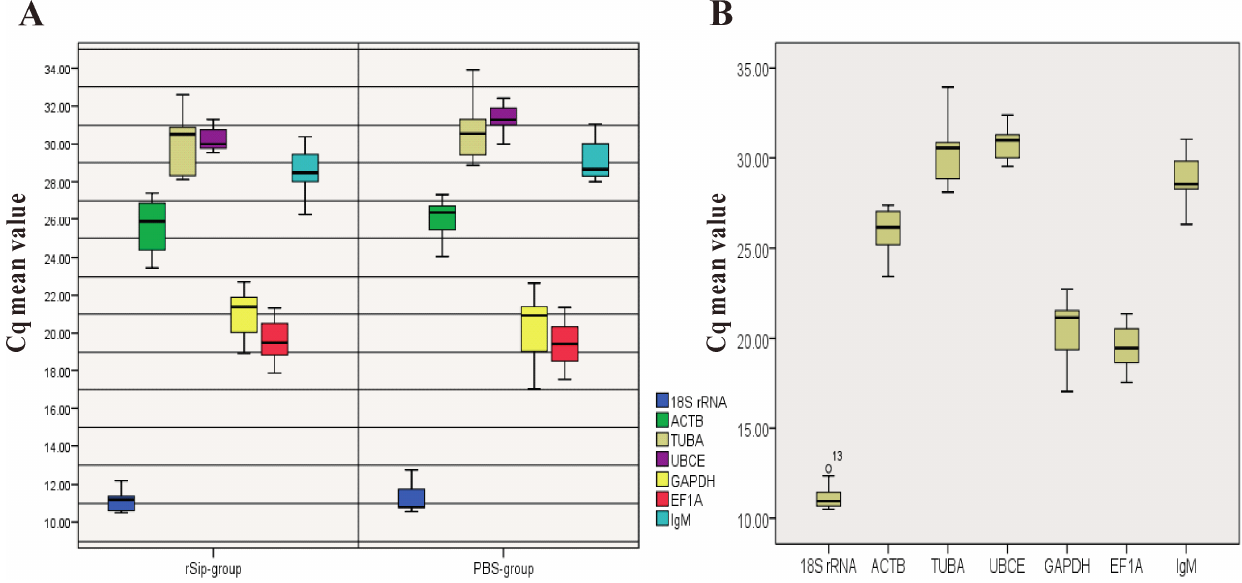
Figure 2. Expression levels of six candidate reference genes and IgM in all experimental sets presented as the C q mean. ( A ) C q values for six reference genes and IgM in the rSip-group and PBS-group. The line across the box is the median. The boxes indicate the 25/75 percentiles. Whisker caps indicate the minimum and maximum values; ( B ) showed C q values for six reference genes and IgM in all samples. The line across the box is the median. The boxes indicate the 25/75 percentiles. Whisker caps indicate the minimum and maximum values. The circles represent the